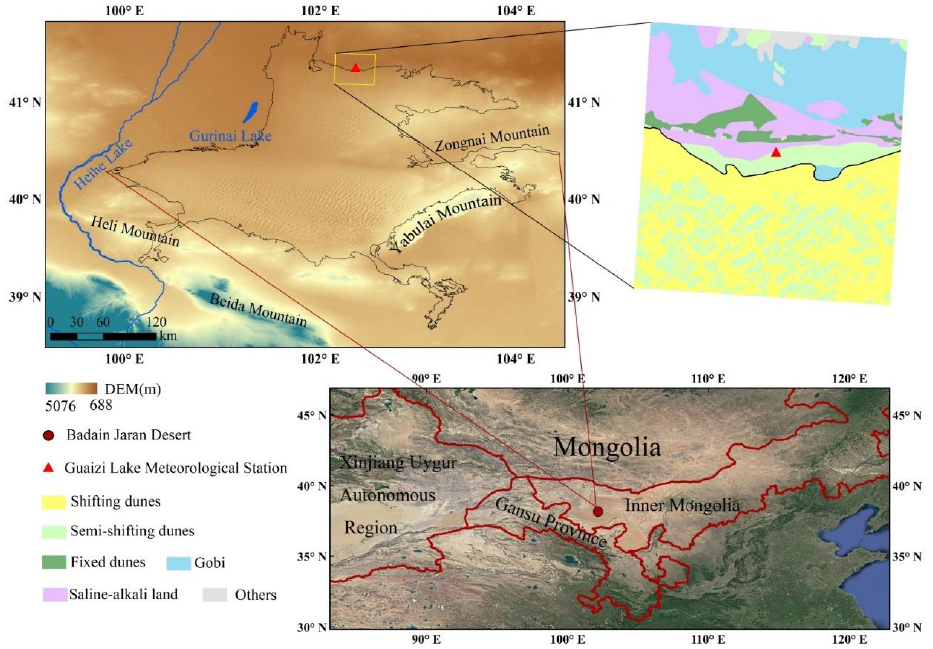
Figure 1. The location of meteorological station and different underlying surfaces of the study area. DEM and the study area within the China map are from the Geospatial Data Cloud (http://www.gscloud.cn (accessed on 5 April 2021)) and Google Earth, respectively.